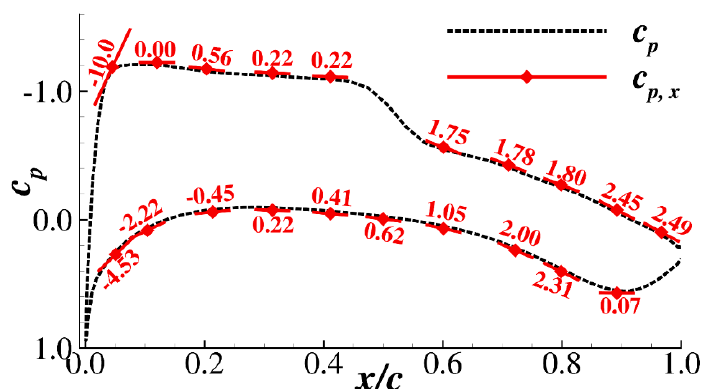
Figure 4. Pressure gradient target of a supercritical type airfoil.